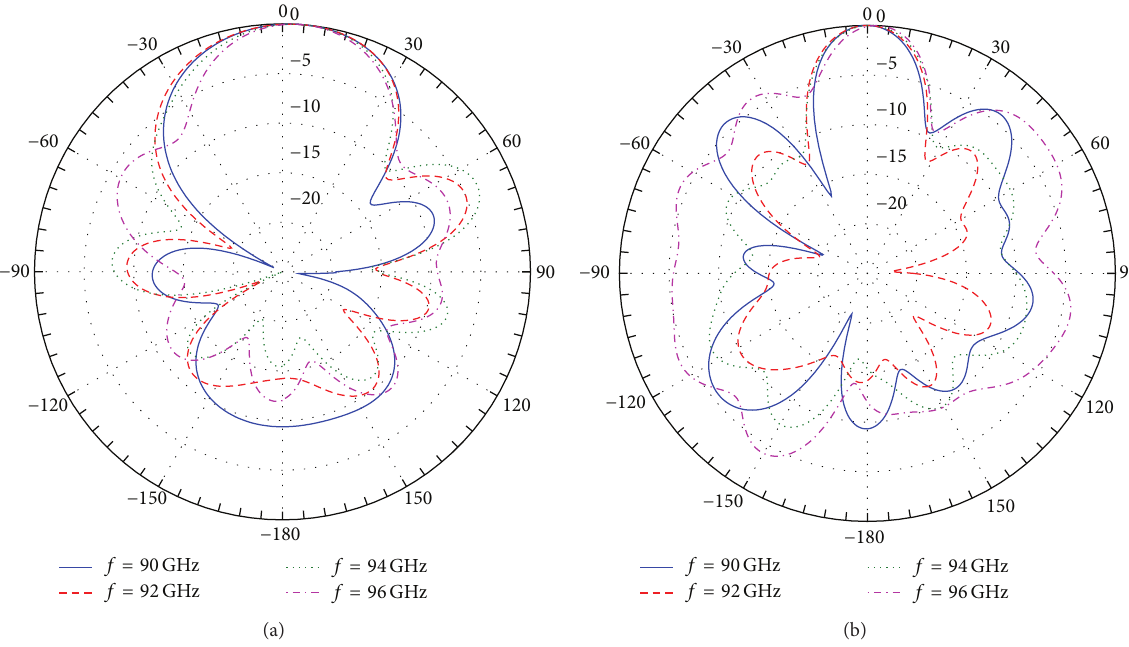
Figure 8: Simulated radiation patterns in (a) 𝑌𝑍 plane and (b) 𝑋𝑌 plane at different frequencies 𝑓 = 90 , 92, 94, and 96 GHz for the Quasi-Yagi dipole array antenna prototype